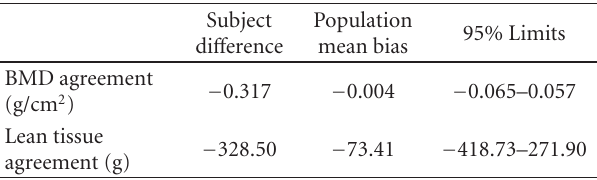
Table 2: Bland-Altman agreement with 95% limits between the left and right legs for BMD and lean tissue in the case report subject and the control